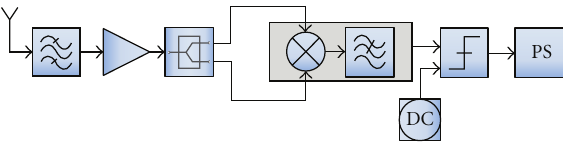
Figure 5: Block diagram of the energy detection receiver.